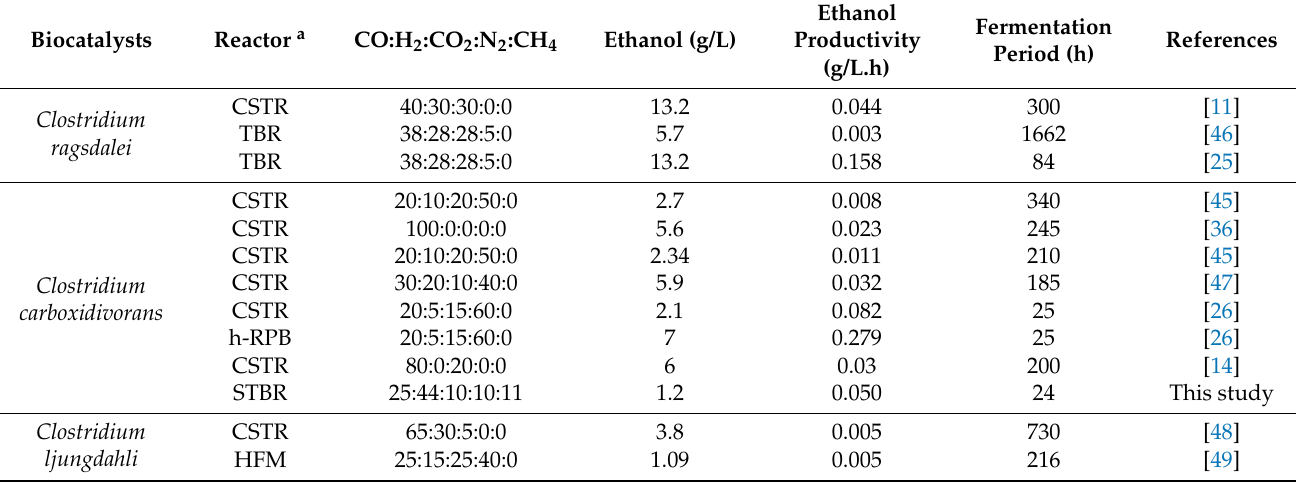
Table 3. Ethanol production from syngas fermentation in different